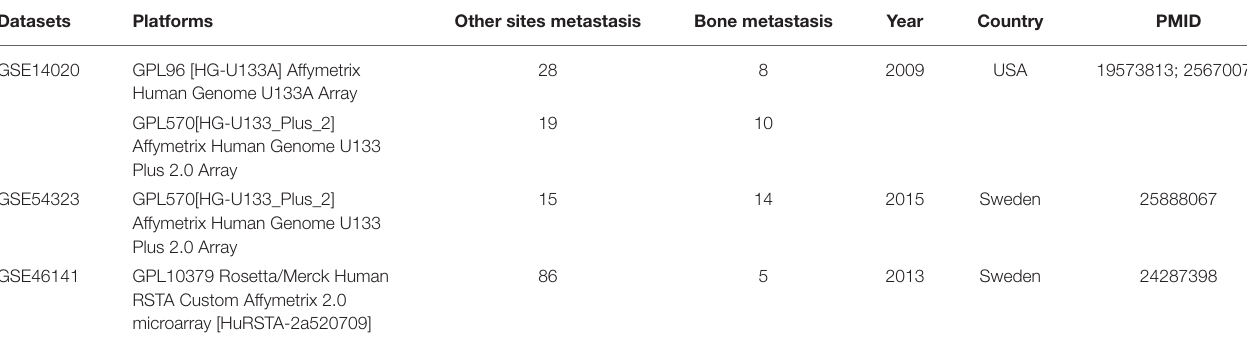
TABLE 1 | Three datasets of selected breast cancer with bone metastasis.